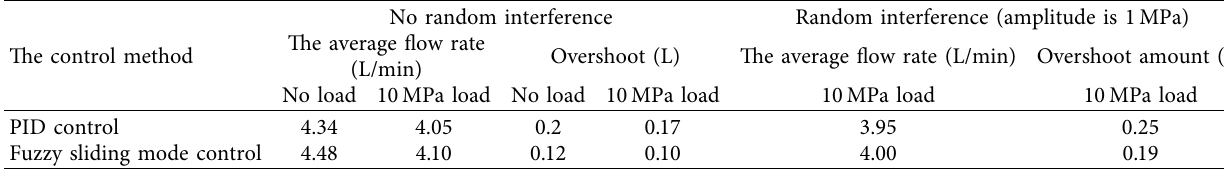
Table 2: Comparison of simulation results under different controllers.